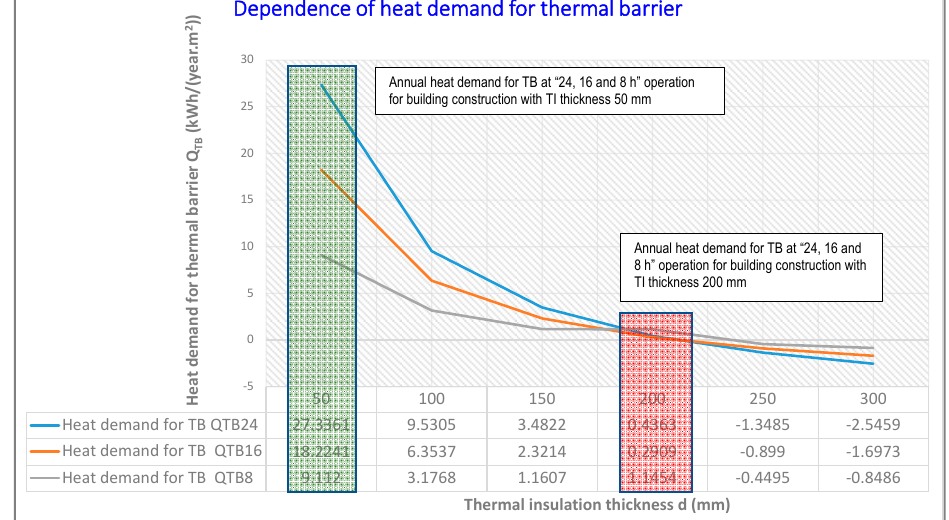
Figure 11. Dependence of heat demand for thermal barrier. Dependence of heat costs for the thermal barrier (€ / (year.m 2 ))